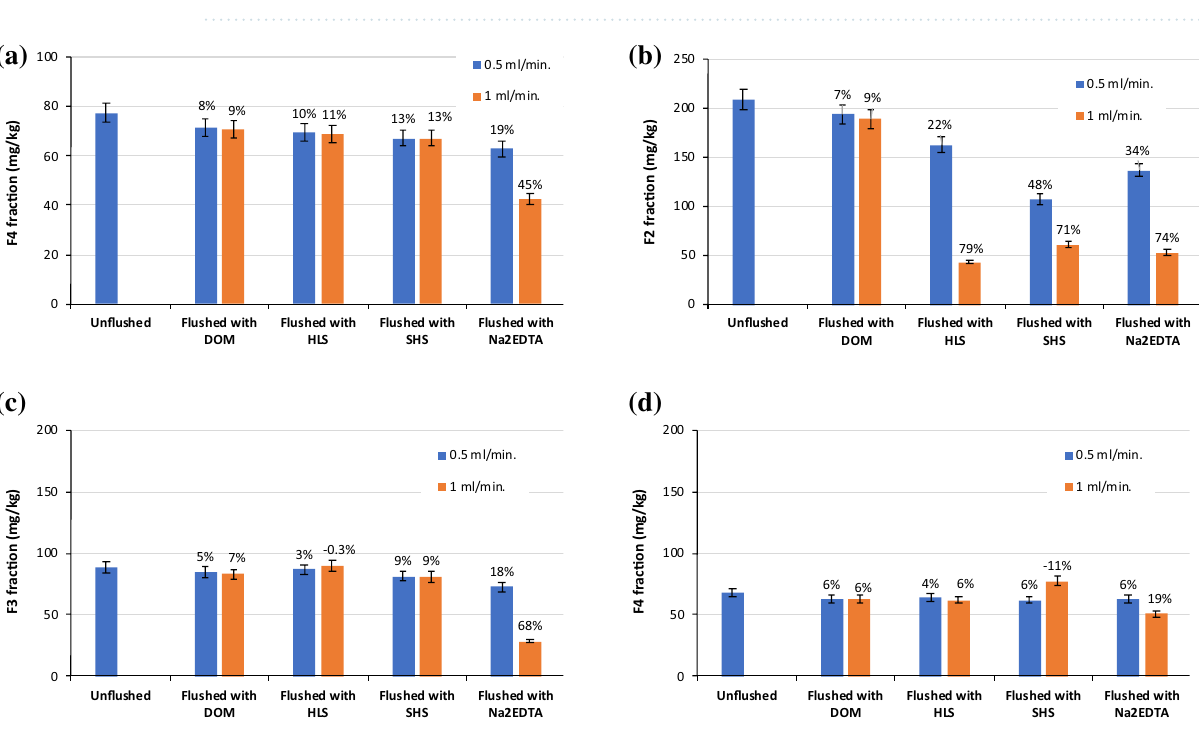
Figure 9. Changes in Pb distribution in unflushed soil and soil flushed with DOM, HLS, SHS and Na 2 EDTA at two flow rates. The values above the bars mean the removal efficiency of Pb from individual fractions: ( a ) F1 fraction, ( b ) F2 fraction, ( c ) F3 fraction, ( d ) F4 fraction. Data are expressed as mean values (n = 2) ± standard deviation error